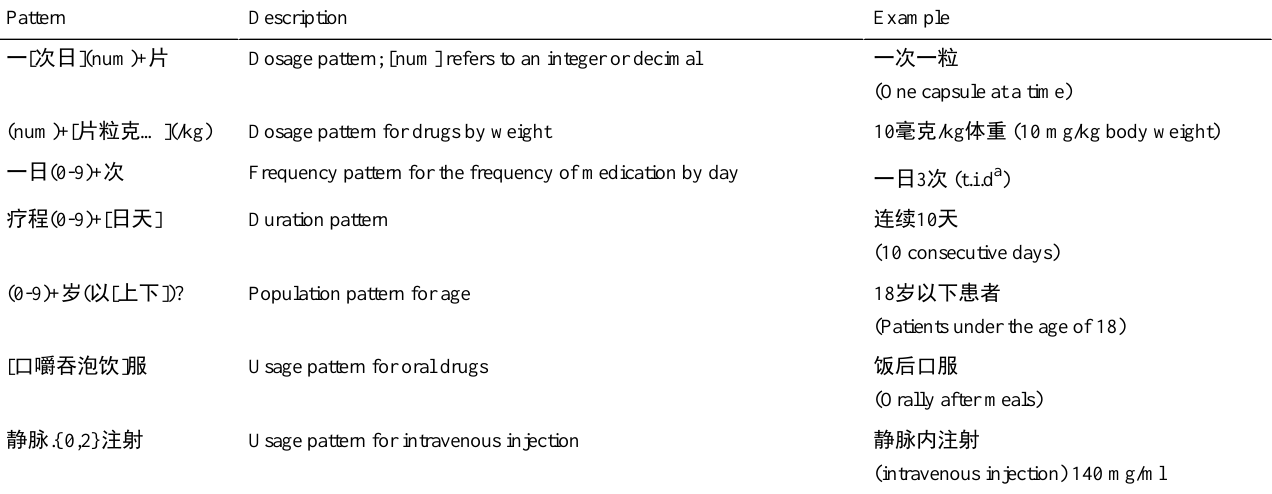
Table 2. Patterns of property value extraction described by regular expression-like